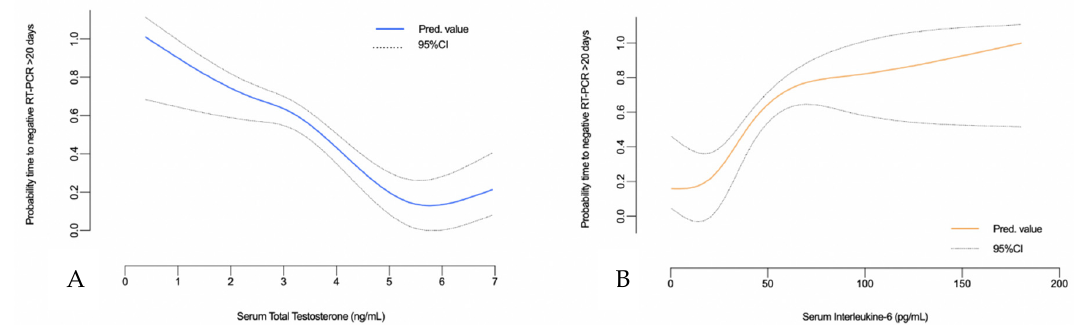
Figure 2. Multivariable adjusted Locally Weighted Scatter-Plot Smoother (LOWESS) function depicting the predicted probability of time to negative RT-PCR > 20 days and the increasing levels of serum total testosterone ( A ) and Interleukine-6 ( B ) detected at hospital admission.